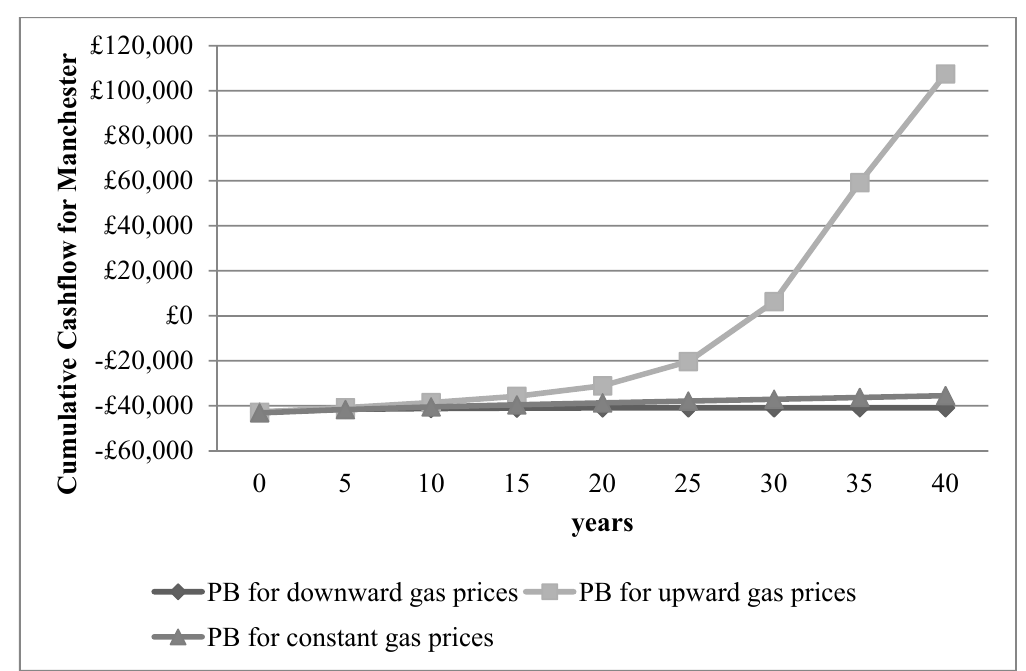
Figure 19. Cumulative cash flow of the refurbished house for current and future Manchester weather data over 40 years for different gas price trends.